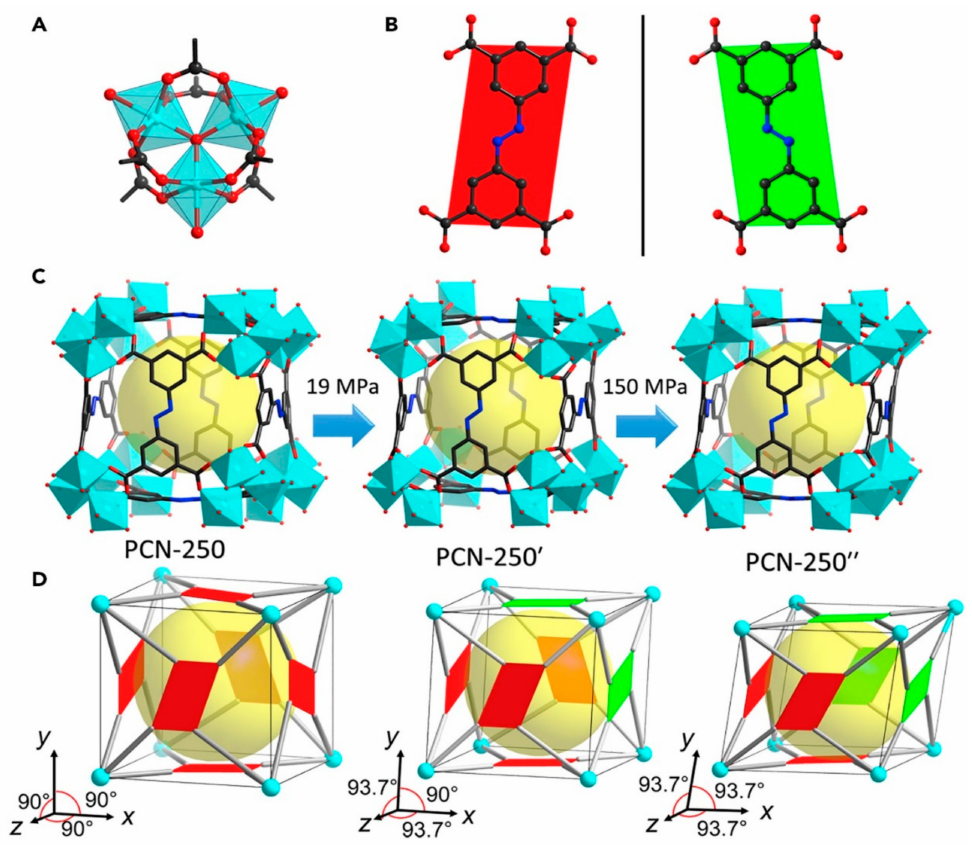
Figure 10. Shows the illustration of possible transformations that PCN-250 can undergo upon applying mechanical pressure such as the inclination of the unit cell and flipping of linkers, ( A – D ) Structure of ( A ) Fe 3 - µ 3 -oxo cluster; ( B ) ABTC linkers with di ff erent configurations; ( C ) comparison of the crystal structures of PCN-250, PCN-2500, and PCN-25000; ( D ) scheme representation of the structural transformation including the inclination of unit cell and flipping of linkers.